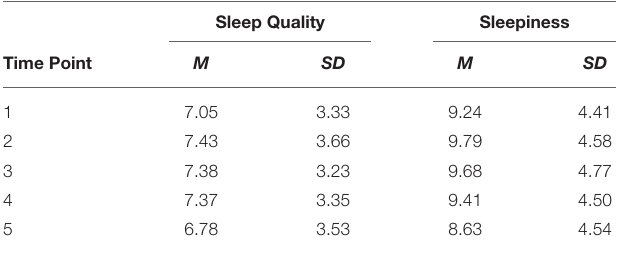
TABLE 1 | Descriptive statistics for sleep quality and sleepiness by time point for all veterinary students. Sleep Quality